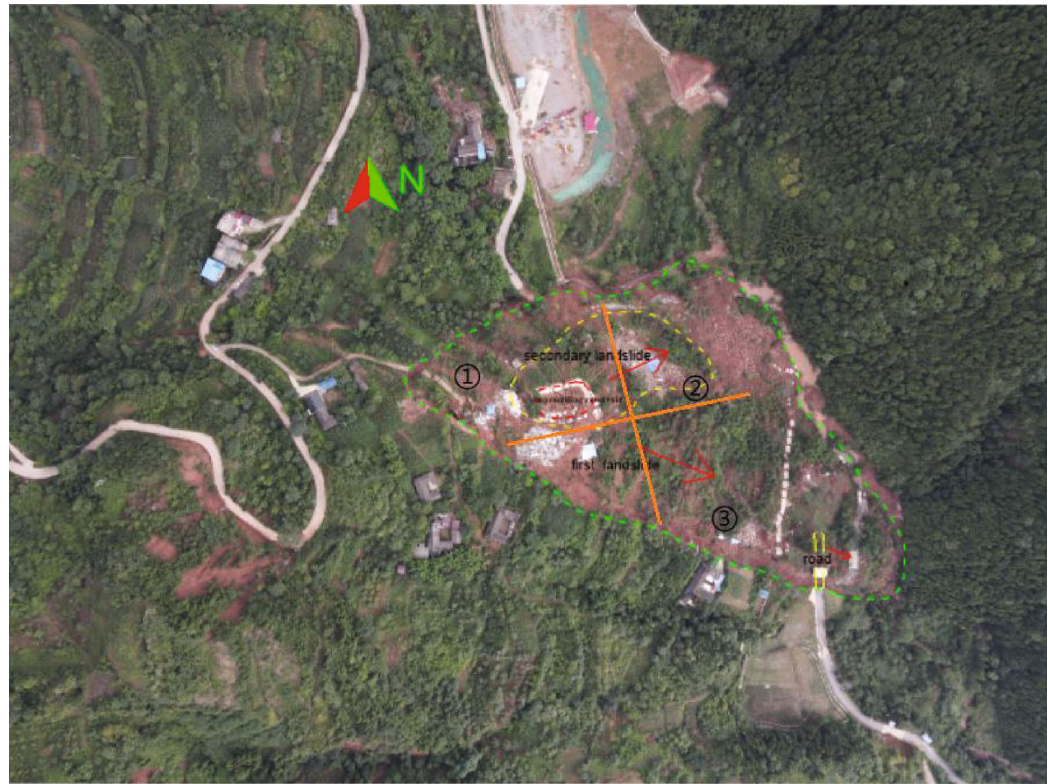
Figure 3: Aerial photo taken by drone. The yellow dotted line indicates the secondary landslide caused by pool collapse, and the red arrow indicates the sliding direction of landslide.